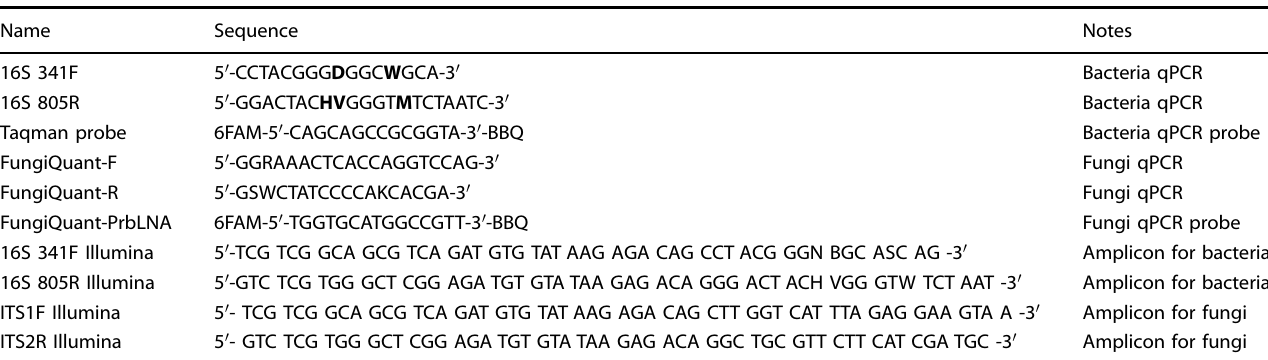
Table 2. List of primers and probes applied in the study.